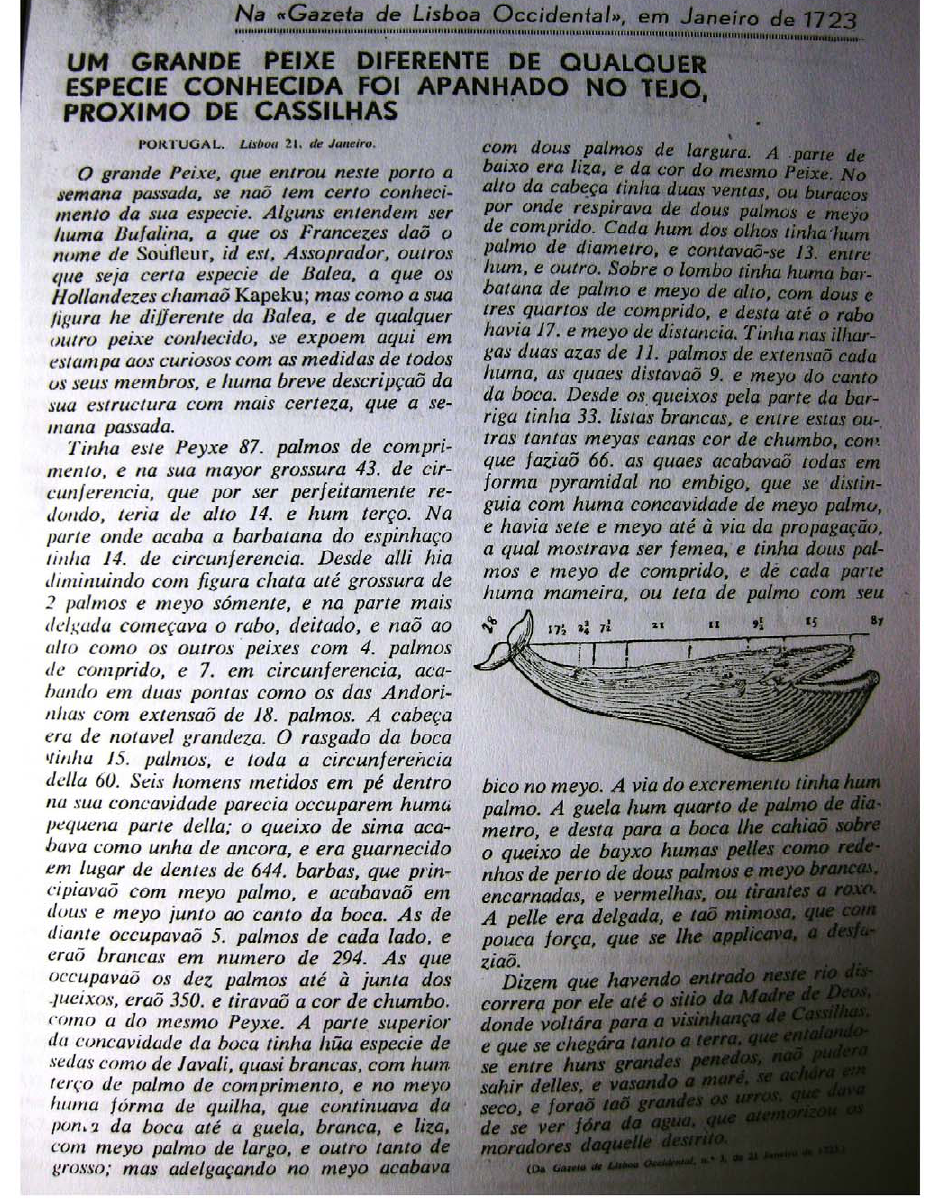
Figure 4. Portuguese newspaper ‘‘ GazetadeLisboaOccidental ’’, dated 21st January 1723, presenting the stranding of a large whale with a very detailed description and an illustration of the